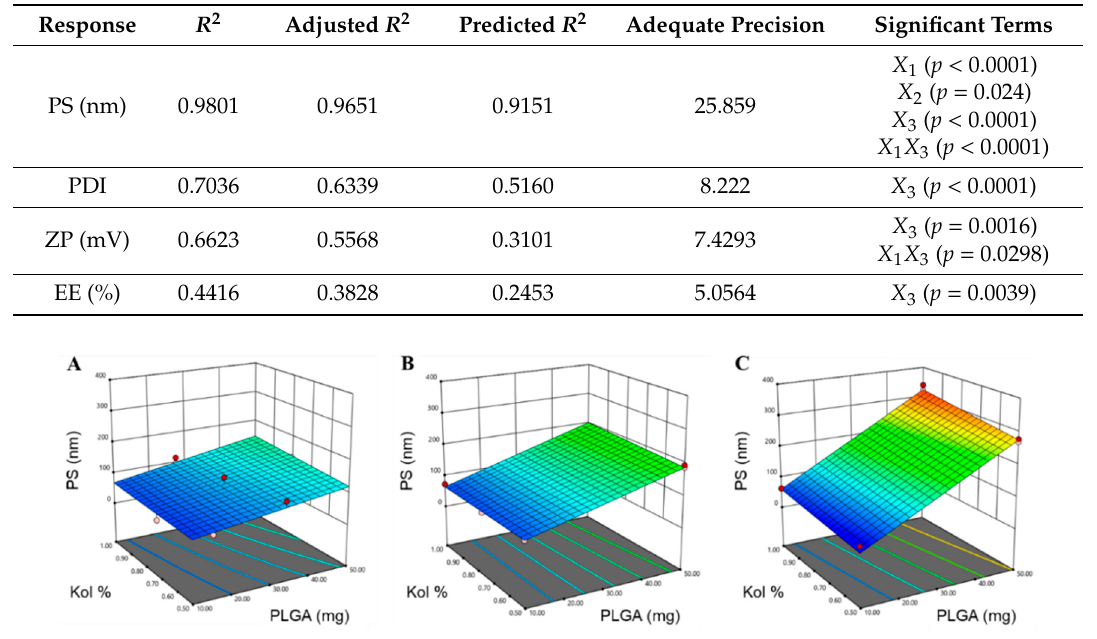
Figure 1. Response surface plots for the effect of the amount of PLGA (mg) and Kol % ( w / v ) on PS using ( A ) PLGA-7K, ( B ) PLGA-24K and ( C ) PLGA-38K. ( A ) PLGA-7K, ( B ) PLGA-24K and ( C ) PLGA-38K.